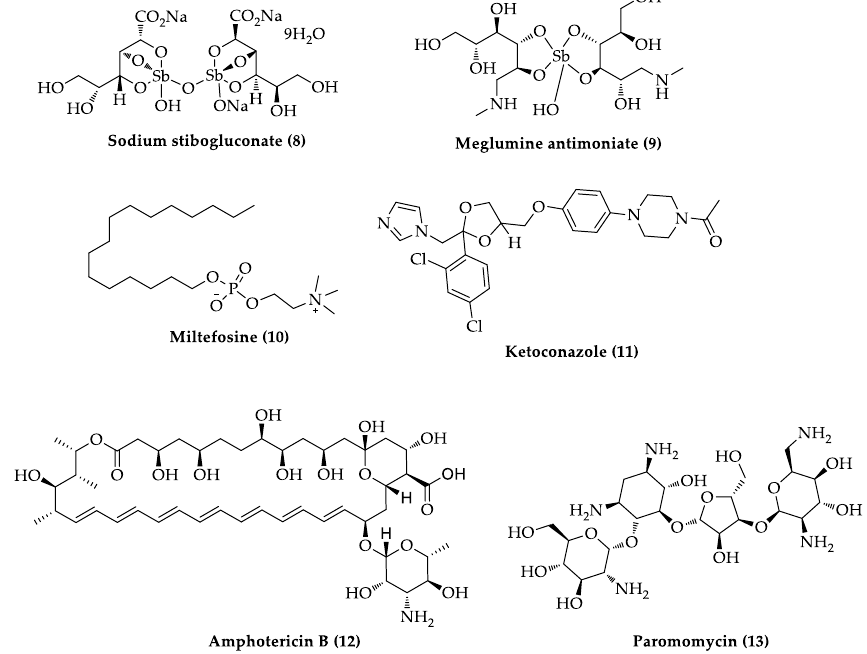
Figure 3. Currently available drugs for leishmaniasis treatment.